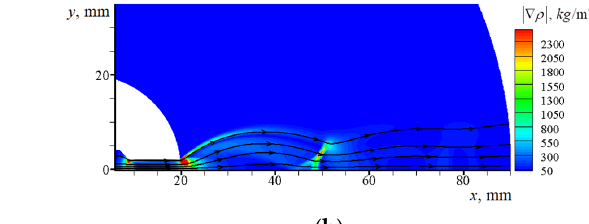
Figure 18. The profile of flow velocity u ( y ) ( a ) and that of momentum flux J p ( y ) ( b ) calculated in the cross-section x = 70 mm. The solid line and the dashed line show the data, respectively for a two-phase jet and for a gas jet without particles.